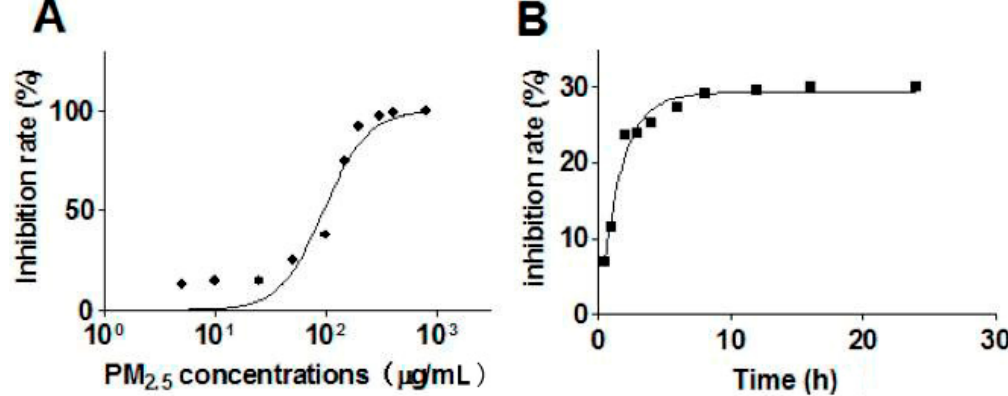
Figure 2. Effects of PM 2.5 concentrations and exposure times on HaCaT cells viability. ( A ) HaCaT cells were treated with different concentrations of fine particles (PM 2.5 ) (from 0 to 800 µ g/mL) for 24 h; HaCaT cell viability maintained a low level with lower doses of PM 2.5 , and, when the concentrations of PM 2.5 exceeded 50 µ g/mL, the damage of the cells increased significantly; ( B ) HaCaT cells were treated with 50 µ g/mL PM 2.5 , and the CCK-8 assay was used to detect cell viability at 2 h, 3 h, 4 h, 6 h, 8 h, 12 h, 16 h, and 24 h respectively. (Each analysis was carried out three times